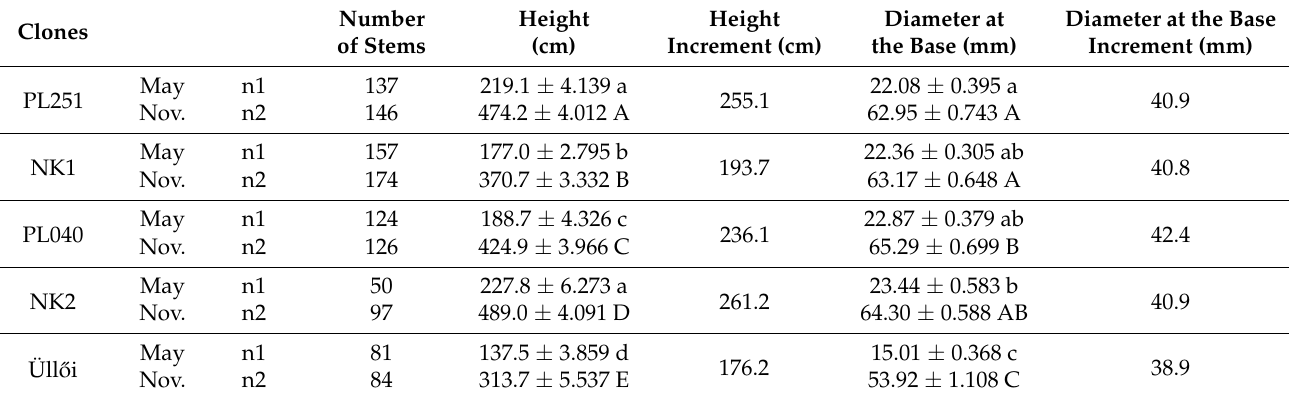
Table 3. Summary of the data from full inventories (May 2021 and November 2021).